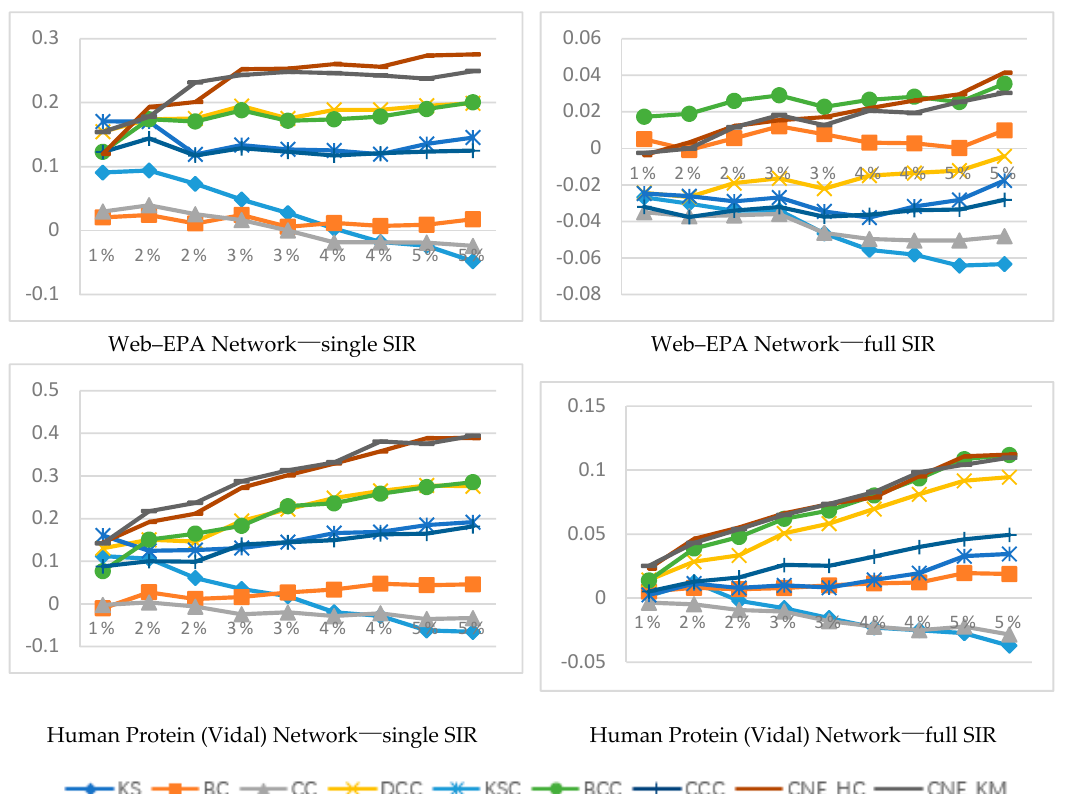
Figure 5. The relative proportion index of node group influence ∆ varies with the number of nodes. From left to right, the experimental results of single-point contact SIR and full-contact SIR models are respectively corresponding to the dataset.